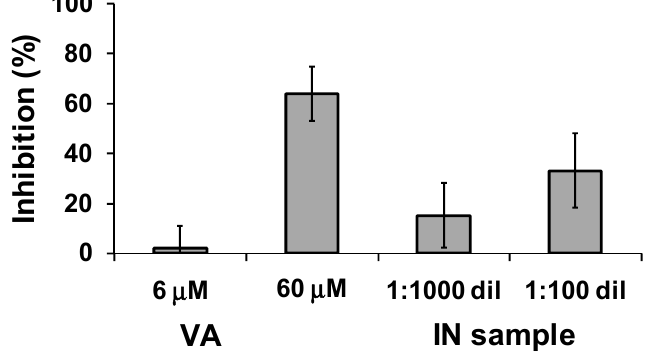
Figure 4. Inhibition of BACE-1 by VA and IN sample. Reported are the mean ± SD values from at least three experiments.